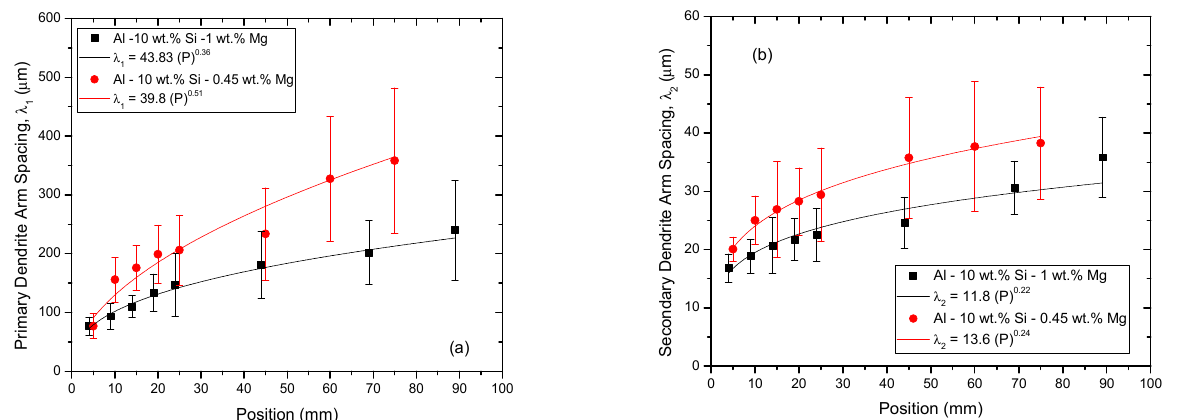
Figure 8. Experimental variations of ( a ) λ 1 and ( b ) λ 2 against position from the metal–mold interface along the length of the Al-10 wt.% Si-1 wt.% Mg and Al-10 wt.% Si-0.45 wt.% Mg alloys castings.